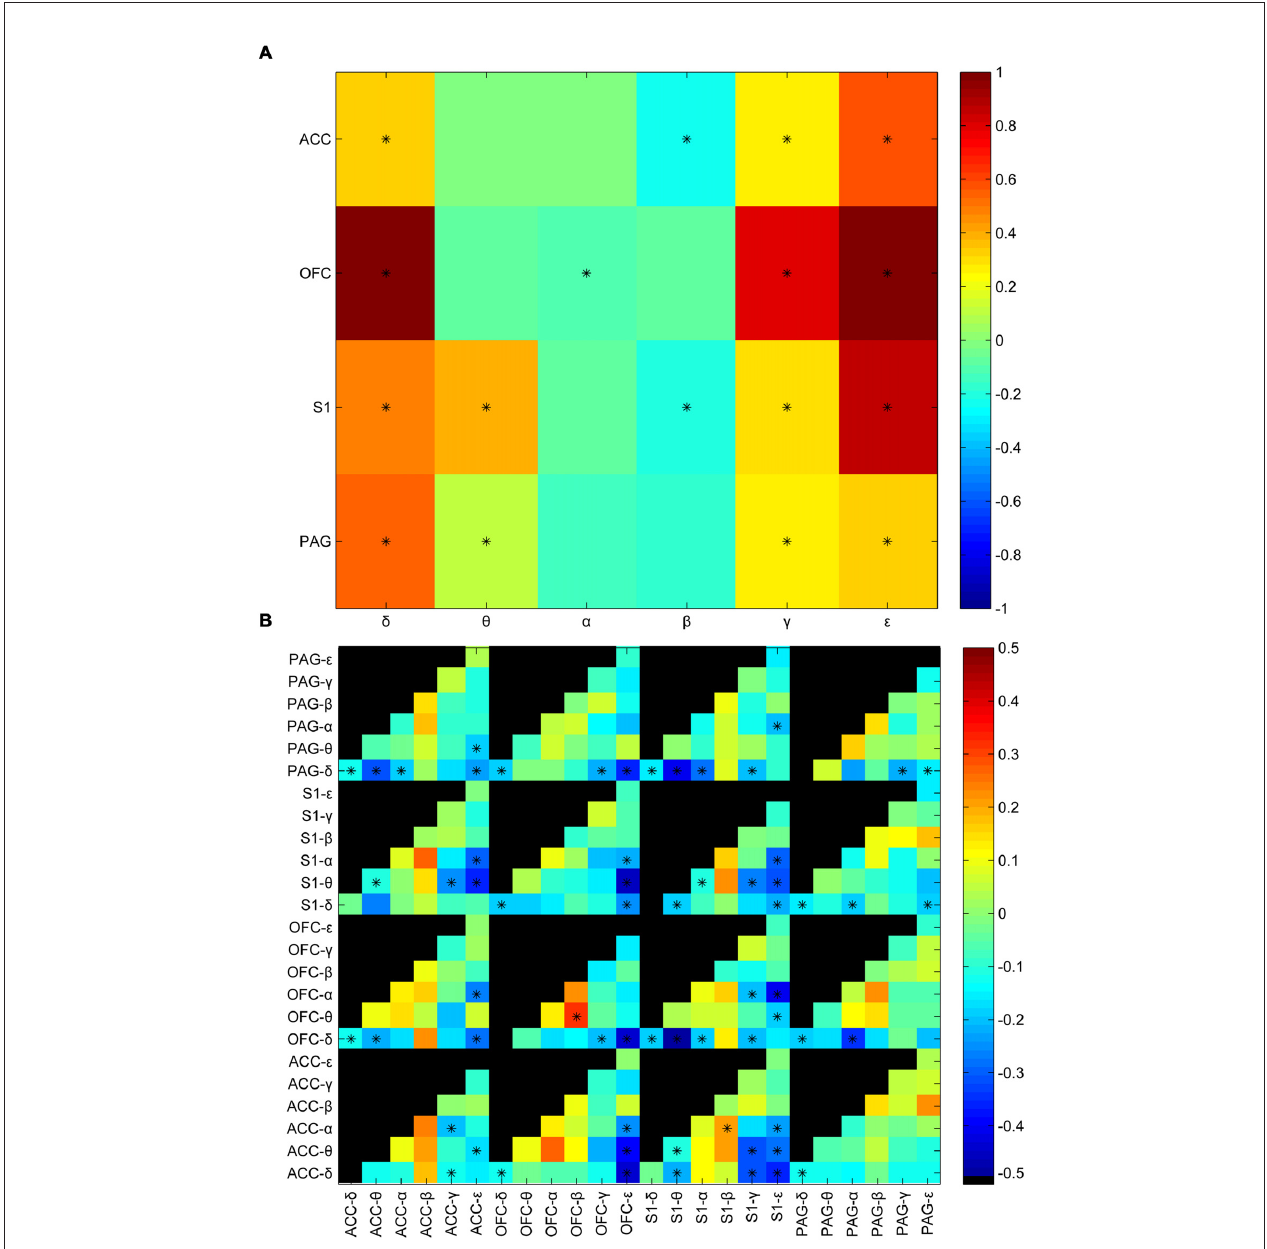
FIGURE 2 | Laser-induced oscillatory changes between noxious and innoxious groups. (A) Averaged power difference in the post stimulus time window within brain areas (anterior cingulate cortex (ACC), orbitofrontal cortex (OFC), primary somatosensory cortex (S1) or periaqueductal gray (PAG)) between noxious group and innoxious group. Different colors indicate the power difference (Blue to Red correspond to − 0.5 to 0.5). Prominent power increase is observed in δ , γ and ε bands in all recorded areas. Power decreases in α and β bands in ACC, S1 and PAG. Asterisks indicate statistical significance ( ∗ p < 0.05, Holm-Bonferroni test). (B) Averaged difference of amplitude envelop correlation (AEC) in the post stimulus time window among different brain areas between noxious group and innoxious group. Normalized mean differences of AEC are indicated by different colors (Blue to Red correspond to − 0.5 to 0.5, Black indicates no value for the corresponding combination). Asterisks indicate statistical significance ( ∗ p < 0.05, Holm-Bonferroni